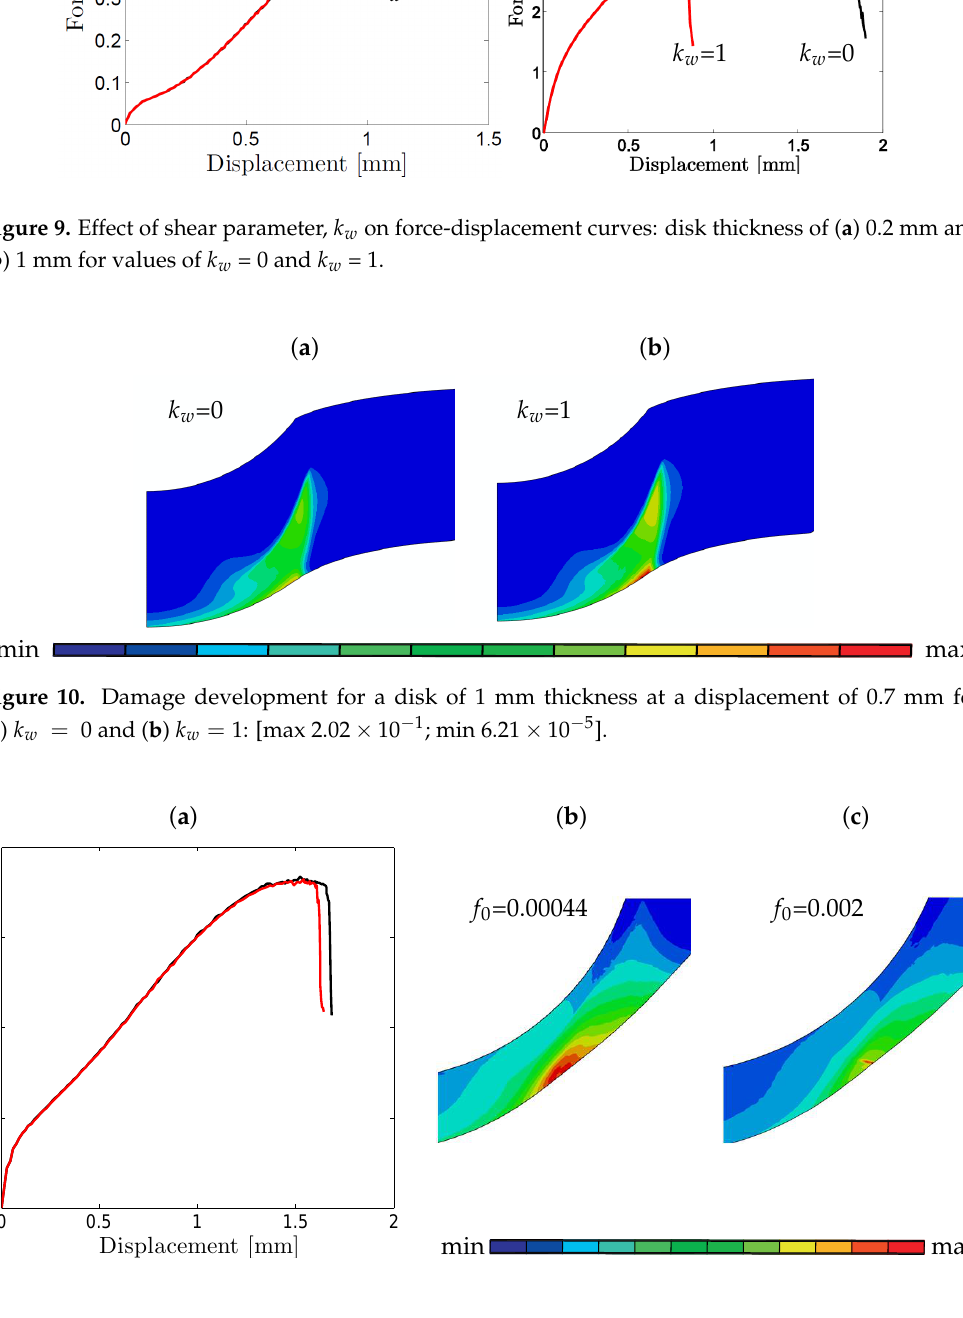
Figure 11. ( a ) Effect of initial porosity f 0 on force-displacement curves of 0.5 mm disk. The red curve represents f 0 = 0.002 whereas the black curve represents f 0 = 0.00044. Damage development for ( b ) f 0 = 0.002 [max 1.08 × 10 − 1 ; min 3.44 × 10 − 5 ] ( c ) f 0 = 0.00044 [max 1.81 × 10 − 1 ; min 1.51 × 10 − 4 ] at punch displacement of 1.6